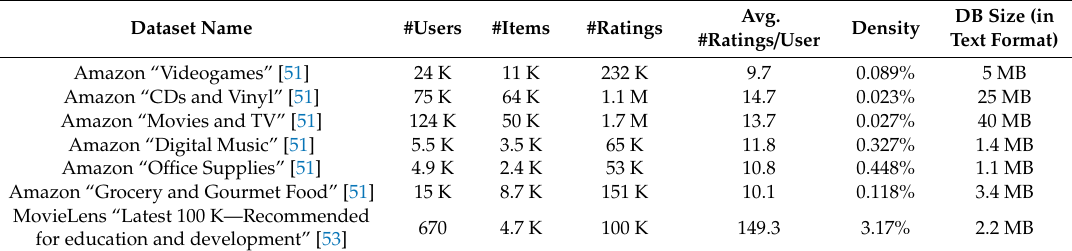
Table 4. Datasets